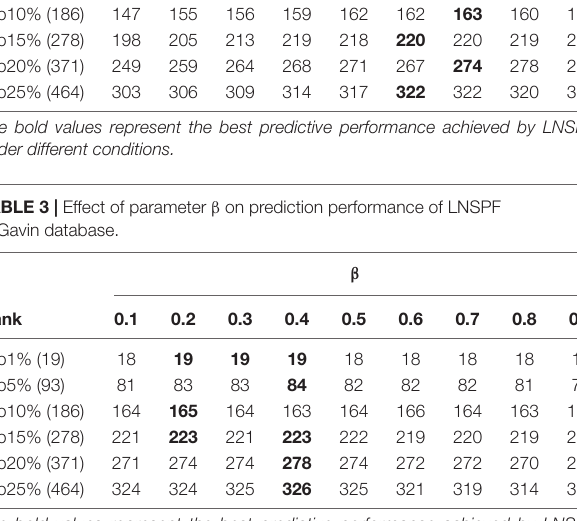
The bold values represent the best predictive performance achieved by LNSPF under different conditions. TABLE 4 | Effect of parameter β on prediction performance of LNSPF based on DIP database.